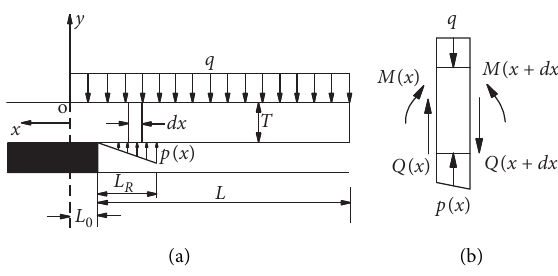
Figure 2: Mechanical model of hard